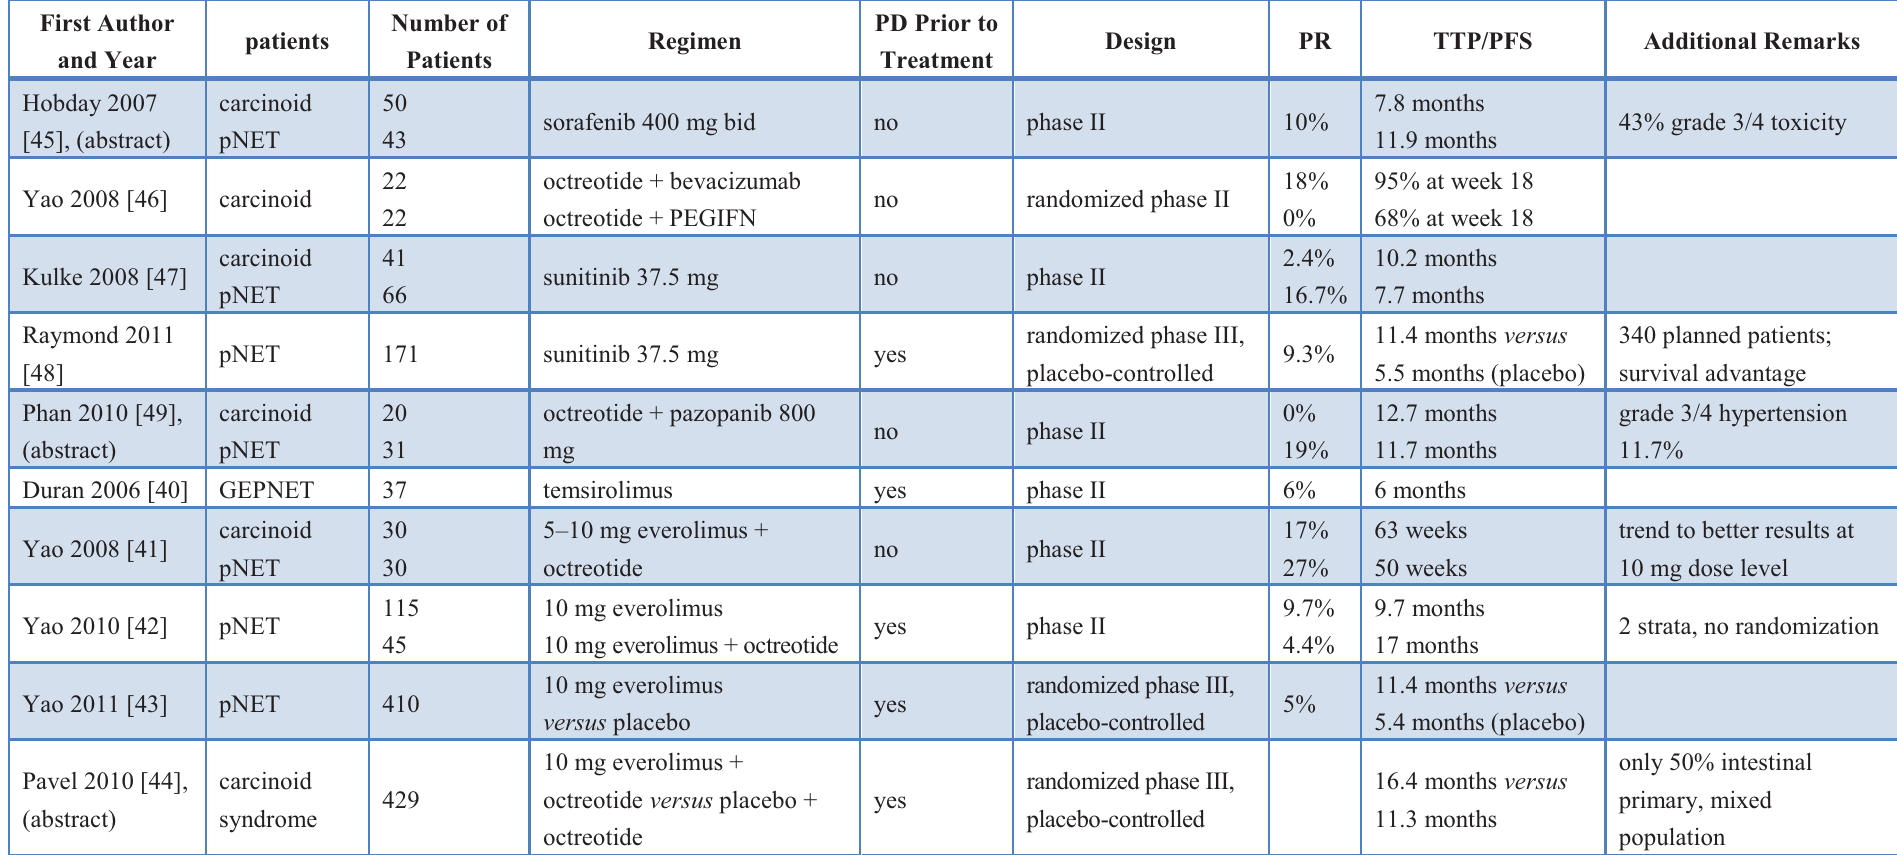
Table 3. Overview on studies with targeted therapies in patients with neuroendocrine